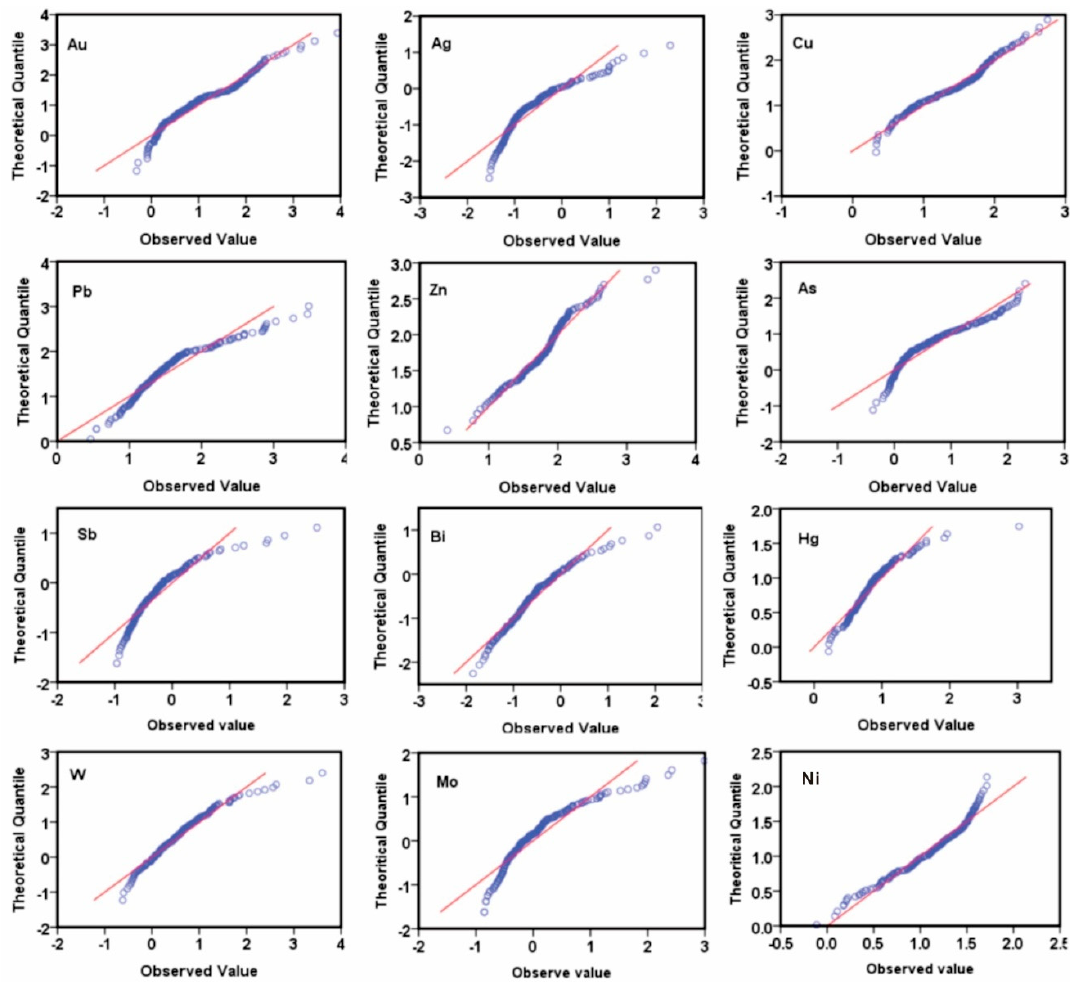
Figure 6. Q–Q plots of log-transformed sectional primary elements data.